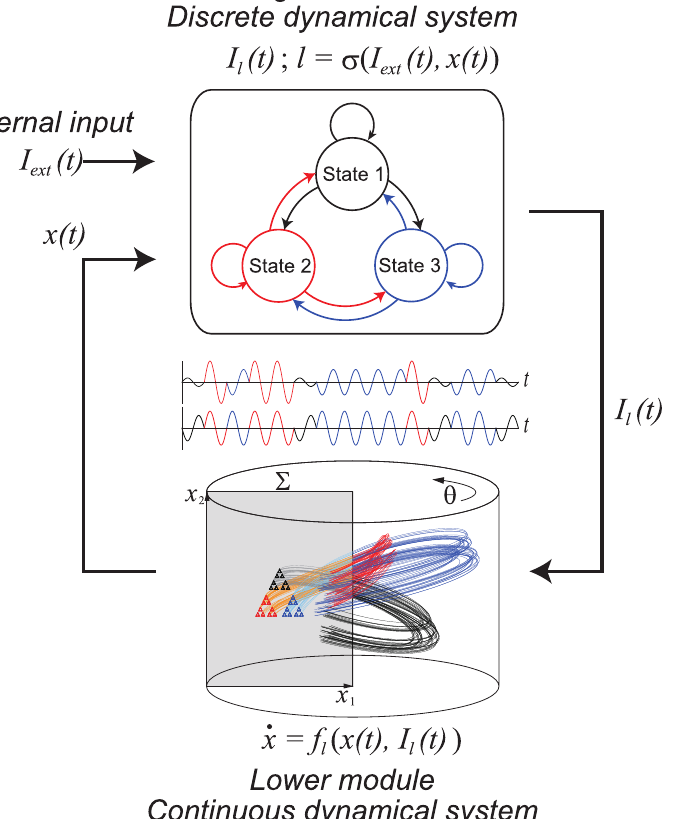
Figure 9. Schematic representation of switching hybrid dynamics, which is composed of a discrete dynamical system as a higher module and a continuous dynamical system as a lower module with a feedback loop. This system is